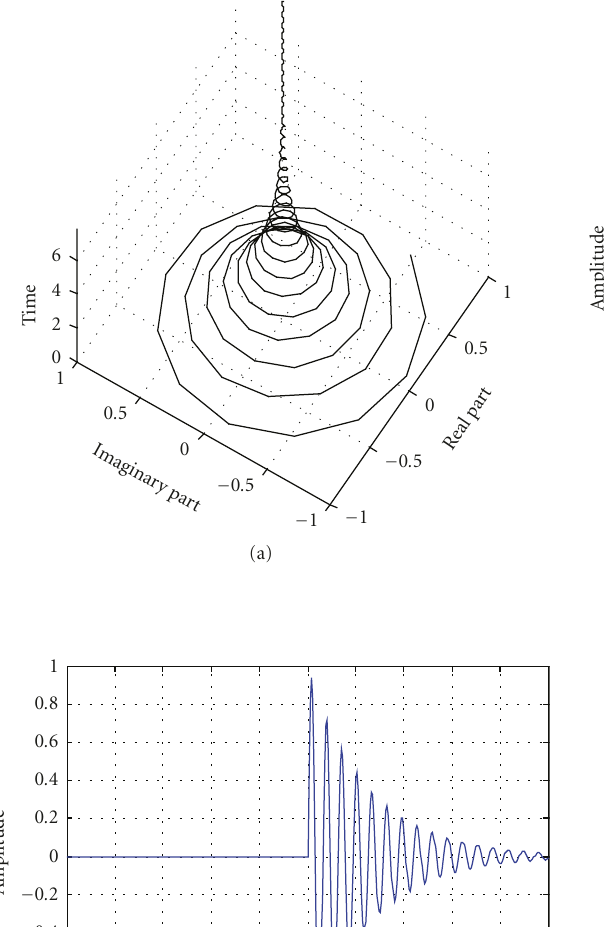
√ a is used to ensure energy preservation. The time-varying , since the analytical 1 / , b function A ( t ) is the instantaneous envelope of the resulting wavelet transform (EWT) which extracts the slow time vari- ation of the signal, and is given by